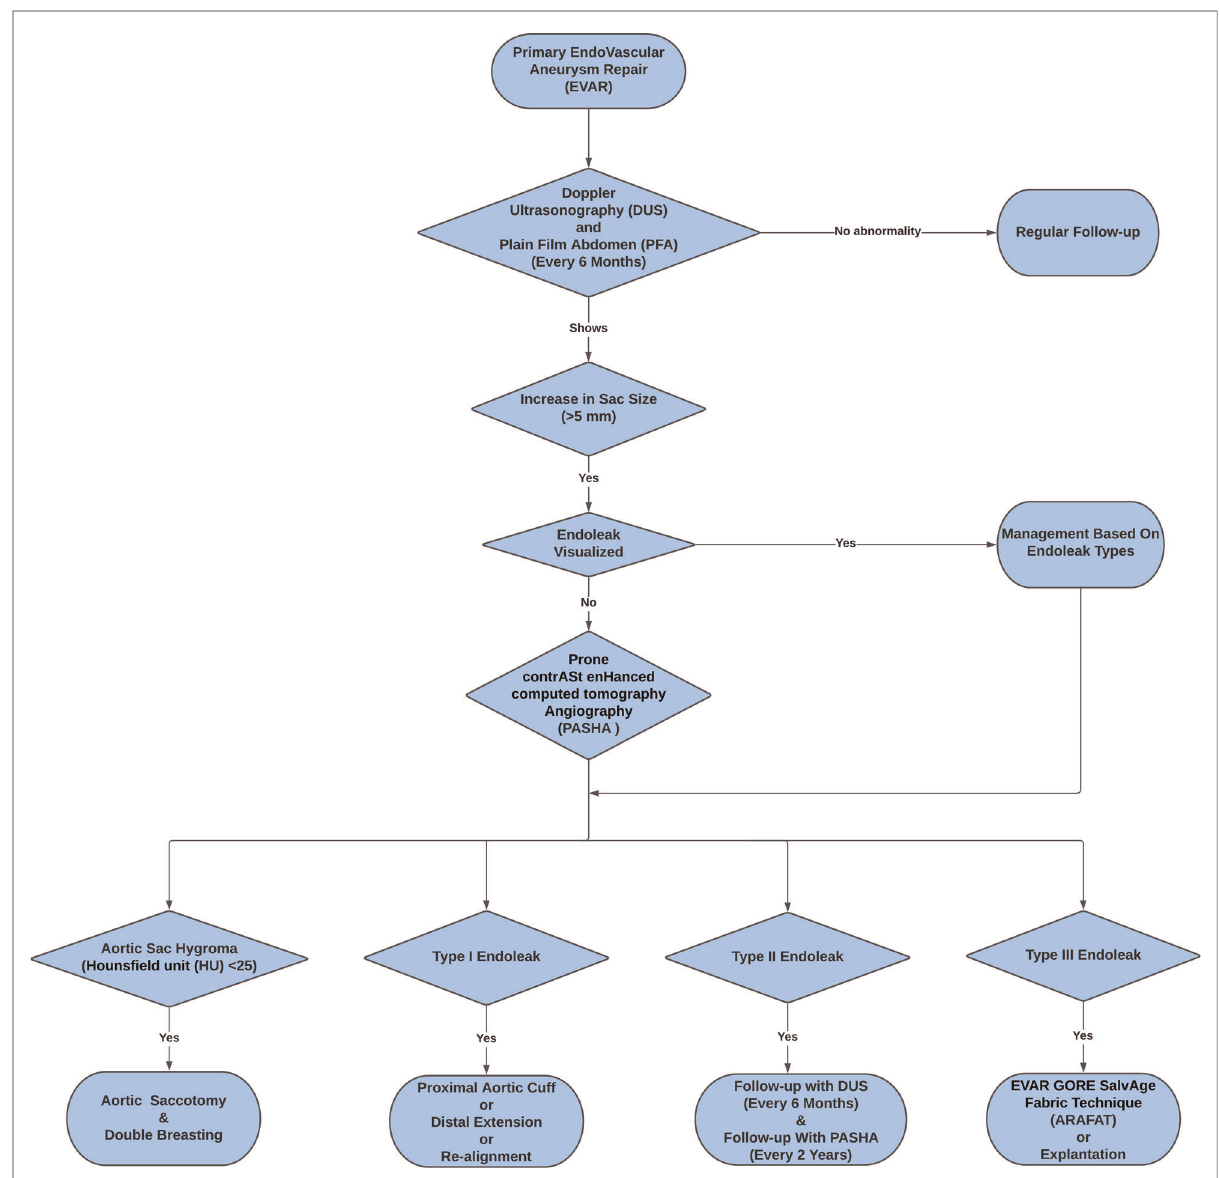
FIGURE 1 Flowchart depicting the adoption of the re-intervention strategies (EVAR GORE SalvAge FAbric Technique (ARAFAT), Double Breasting, and Explantation) following Prone ContrASt EnHanced Computed Tomography Angiography